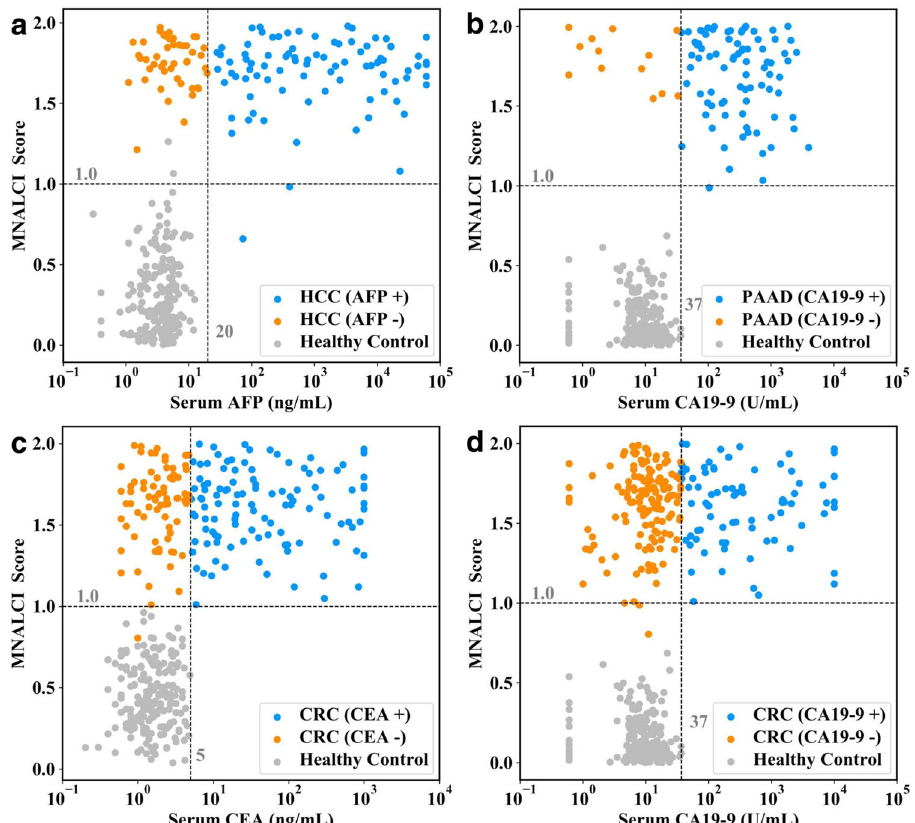
Fig. 4 Comparison between MNALCI and serum tumor antigens in diagnosing speci fi c cancers. The cutoffs for MNALCI score (the horizontal line) were set to 1.0 for the highest accuracy while the cutoffs for tumor antigens (the vertical line) were as per manufacturer ’ s recommendation. a Comparison of the probability by MNALCI with serum AFP for the detection of HCC and healthy control. b Comparison of the probability by MNALCI with serum CA19-9 for the detection of PAAD and healthy control. c Comparison of the probability by MNALCI with serum CEA for the detection of CRC and healthy control. d Comparison of the probability by MNALCI with serum CA19-9 for the detection of CRC and healthy control. Fusion models were applied to all four fi